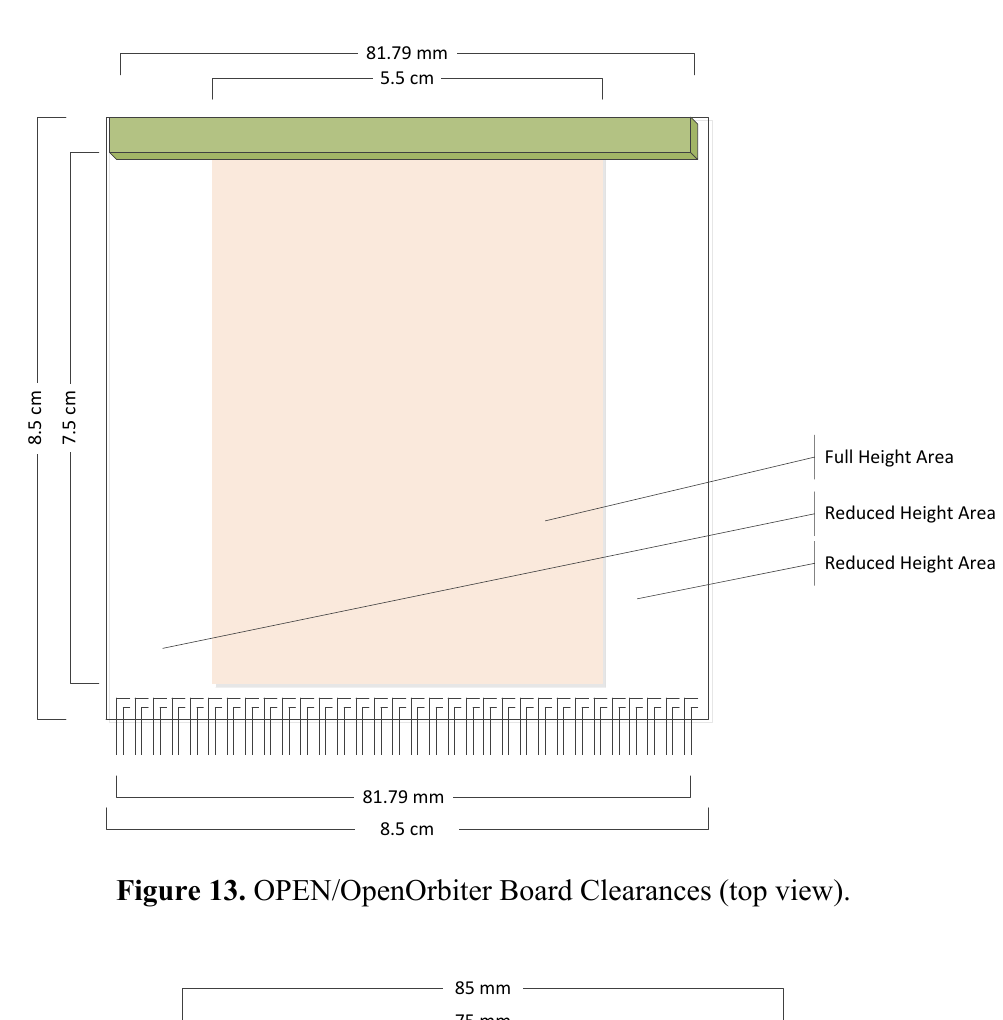
Figure 12. Diagram of OPEN Board Specifications implemented and demonstrated by OpenOrbiter.